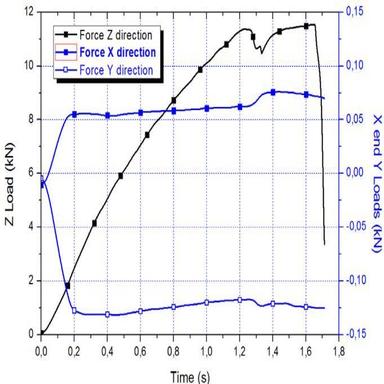
Typical XYZ force components measured with the tri-axial load cell obtained for ψ = 45∘ .